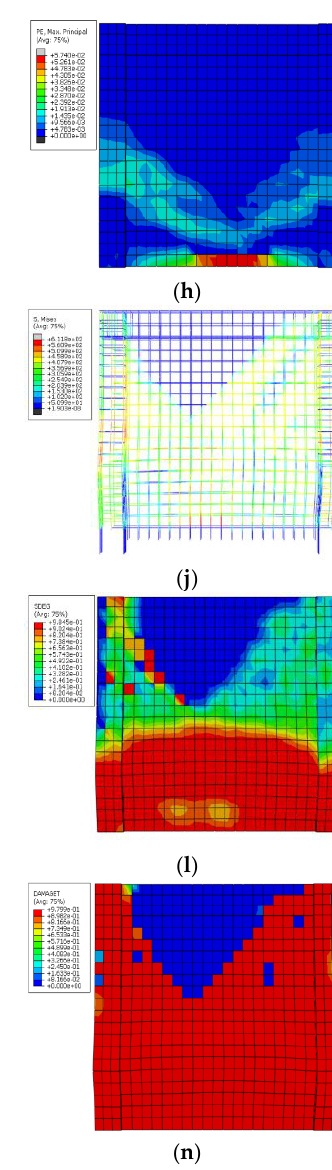
Figure 8. Failure process and failure form of GJ-3. ( a ) The first concrete plastic strain element at the left column foot; ( b ) crack development at the bottom of the wall and columns; ( c ) the first right oblique crack of the shear wall; ( d ) the first left oblique crack of the shear wall; ( e ) the second right oblique crack of the shear wall; ( f ) penetrated cracks appear in the frame column; ( g ) yield of main stressed bars; ( h ) crack penetrated the wall and column; ( i ) the shear wall has cracks developing to the upper right; ( j ) the corresponding cloud chart of the reinforcement when the cracks occur at the upper right; ( k ) the lower part of the wall is bulging; ( l ) cloud chart of stiffness degradation of wall and columns; ( m ) cloud chart of compression failure of GJ-3; ( n ) cloud chart of tension failure of GJ-3.